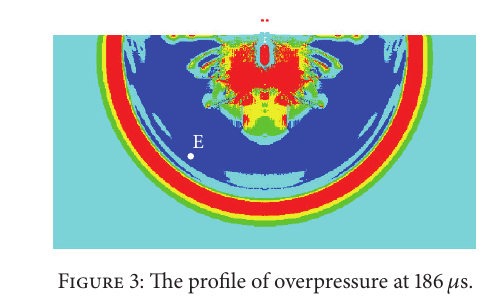
Figure 3: The profile of overpressure at 186 𝜇 s.